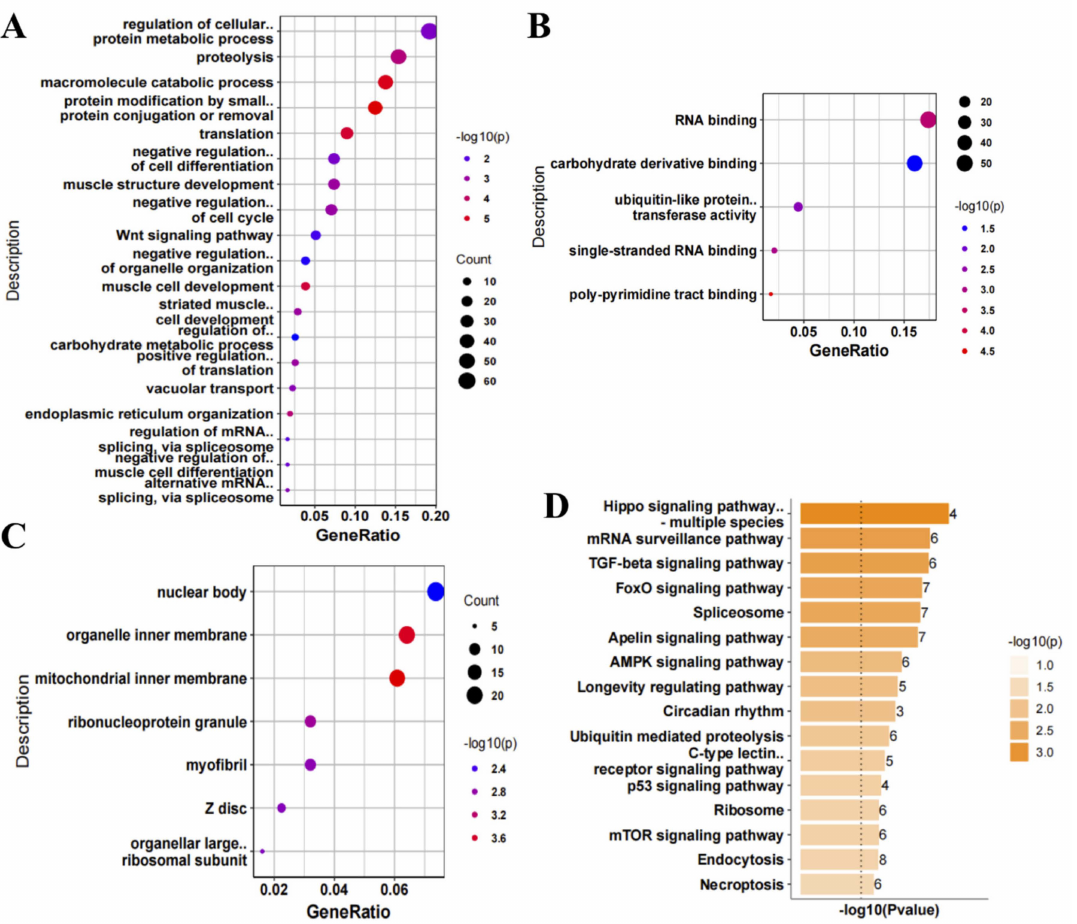
Figure 2. Functional enrichment analysis of up-regulated genes in nerve tissue of amyotrophic lateral sclerosis (ALS) patients. ( A ) Gene Ontology (GO) biological process, ( B ) GO molecular function, ( C ) GO cellular component, and ( D ) Kyoto Encyclopedia of Genes and Genomes (KEGG) analysis of up-regulated genes in the nerve tissue of ALS patients. The number on the right represents the number of differentially expressed